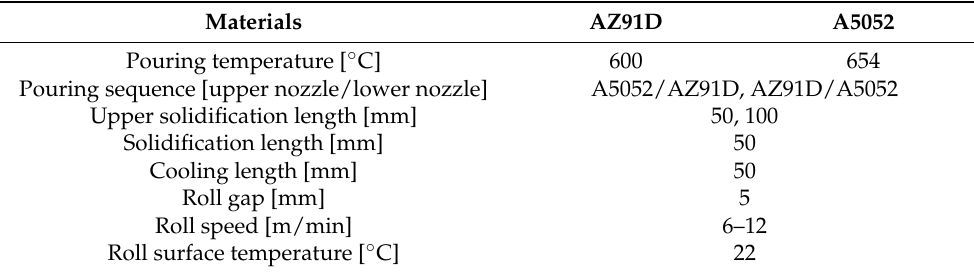
Table 3. Casting conditions for the Mg/Al clad